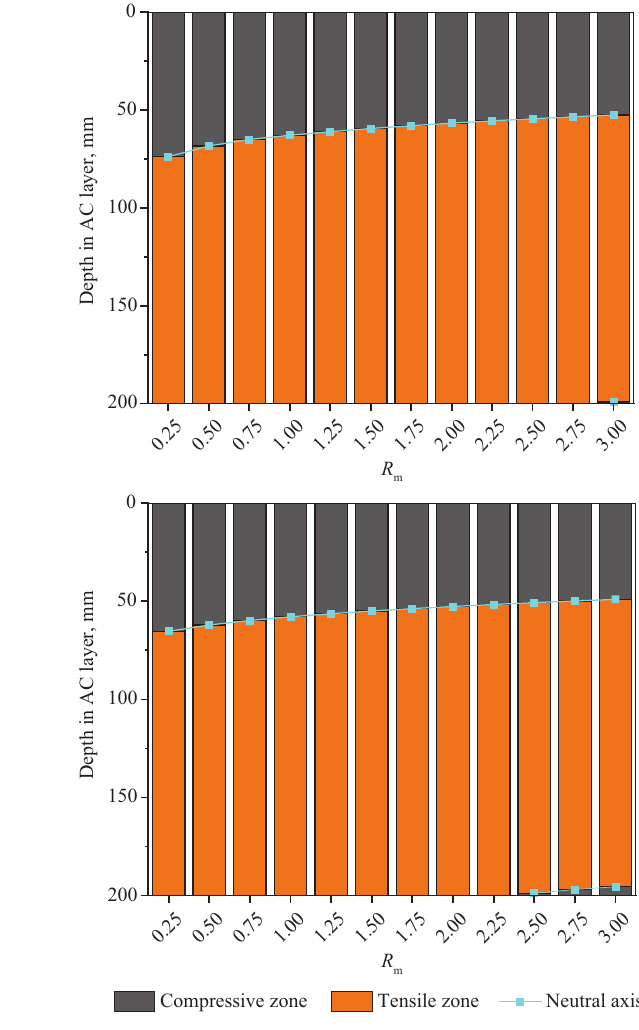
Figure 9. Tensile, compressive zone and the neutral axis in the AC layer: (a) along the driving direction; (b) along the transverse